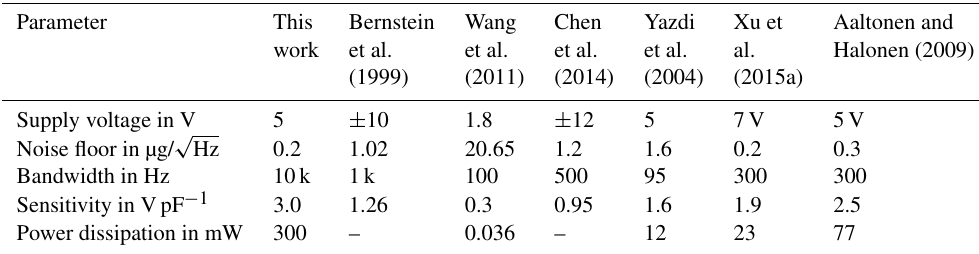
Table 4. Comparison with other systems.